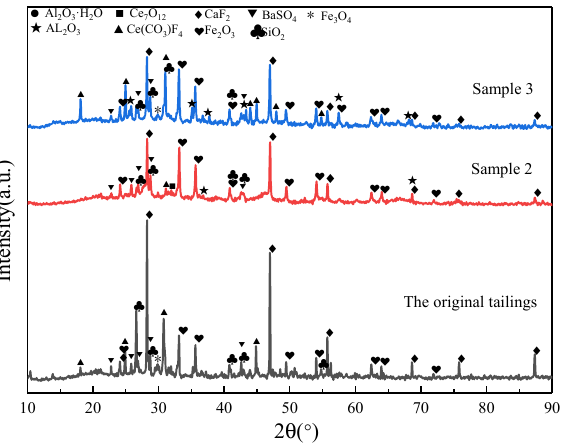
Figure 2. XRD spectrum of the modified catalyst.